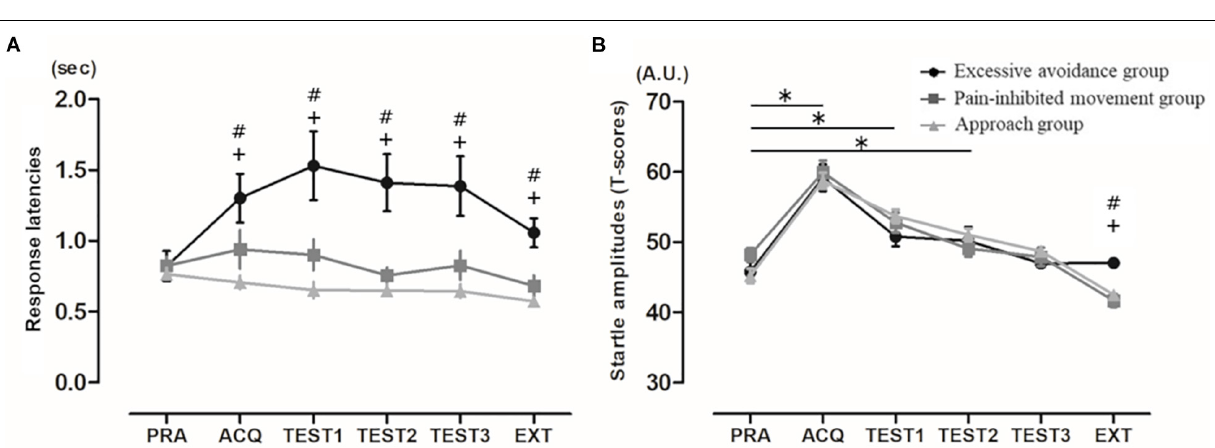
FIGURE 3 | (A) Mean response latencies (mean ± SE). EXT: extinction phase. #: significant difference between clusters 1 and 2, +: significant difference between clusters 1 and 3 ( p < 0.003). (B) Mean startle amplitudes. Mean eyeblink startle amplitudes (mean ± SE). For graphic purposes, T -scores were used. PRA: practice phase. ∗ significant difference between practice phase and other phases, #significant difference between clusters 1 and 2, +: significant difference between clusters 1 and